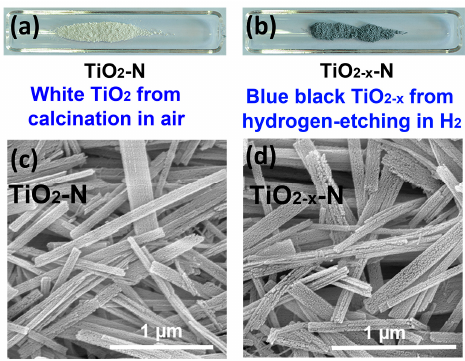
Figure 2. ( a , b ) The photographs of white TiO 2 support calcined in air and blue black TiO 2 − x support calcined in H 2 ; ( c , d ) Scanning electron microscopy (SEM) images of TiO 2 − x ‐ N and TiO 2 ‐ N.